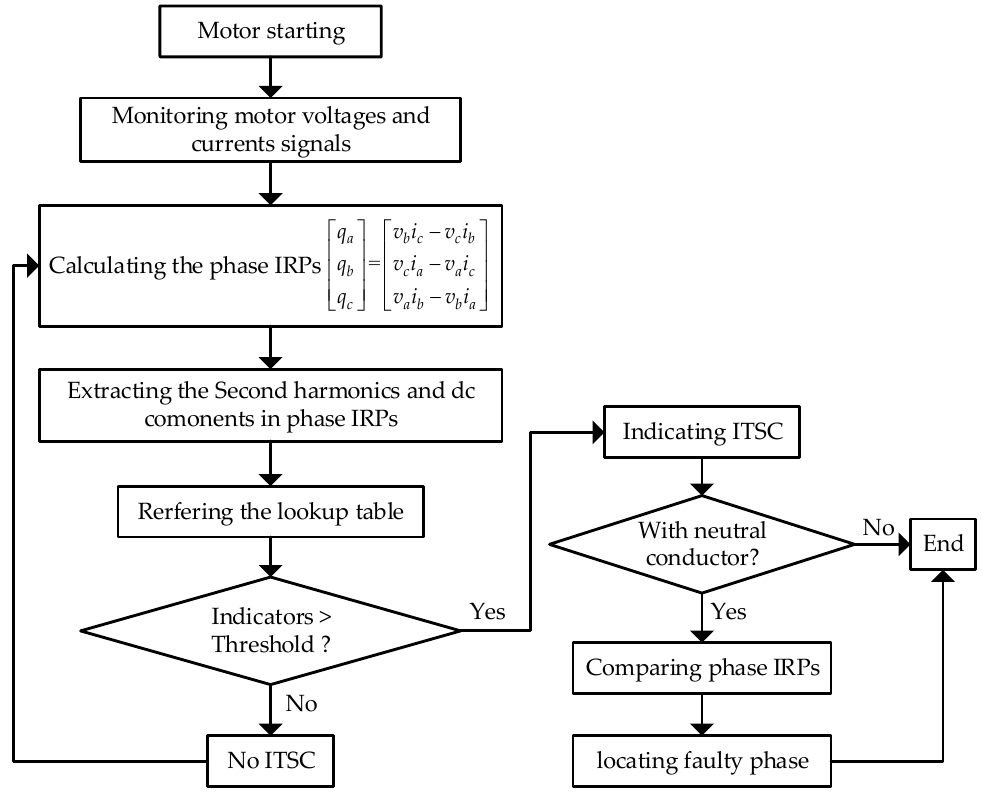
Figure 14. The flowchart of the online detection algorithm.